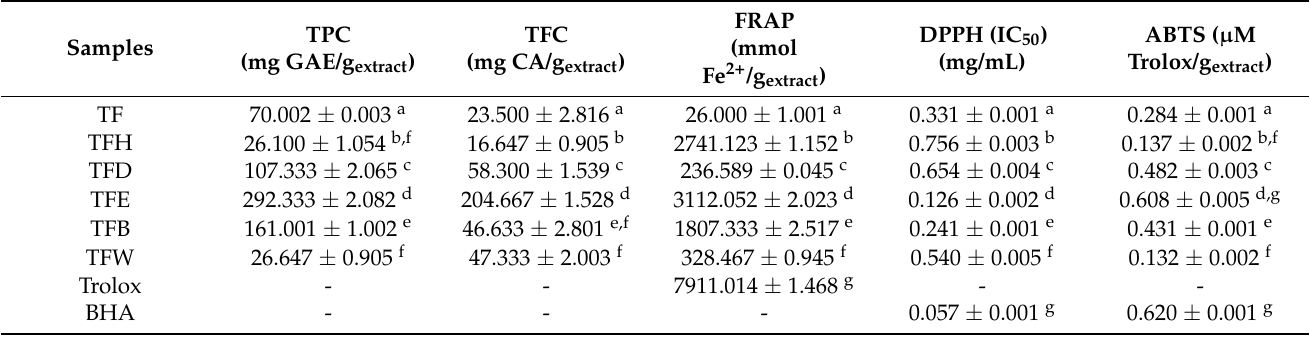
Table 2. Total phenolic and flavonoid content and antioxidant activity results of R. iconiensis flower extracts and